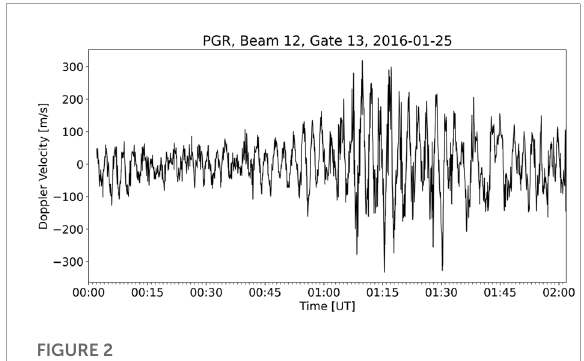
FIGURE 2 Doppler velocity time series from beam 12 and gate 13 of the Prince George radar at 00:00–02:00 UT on 25 January 2016.